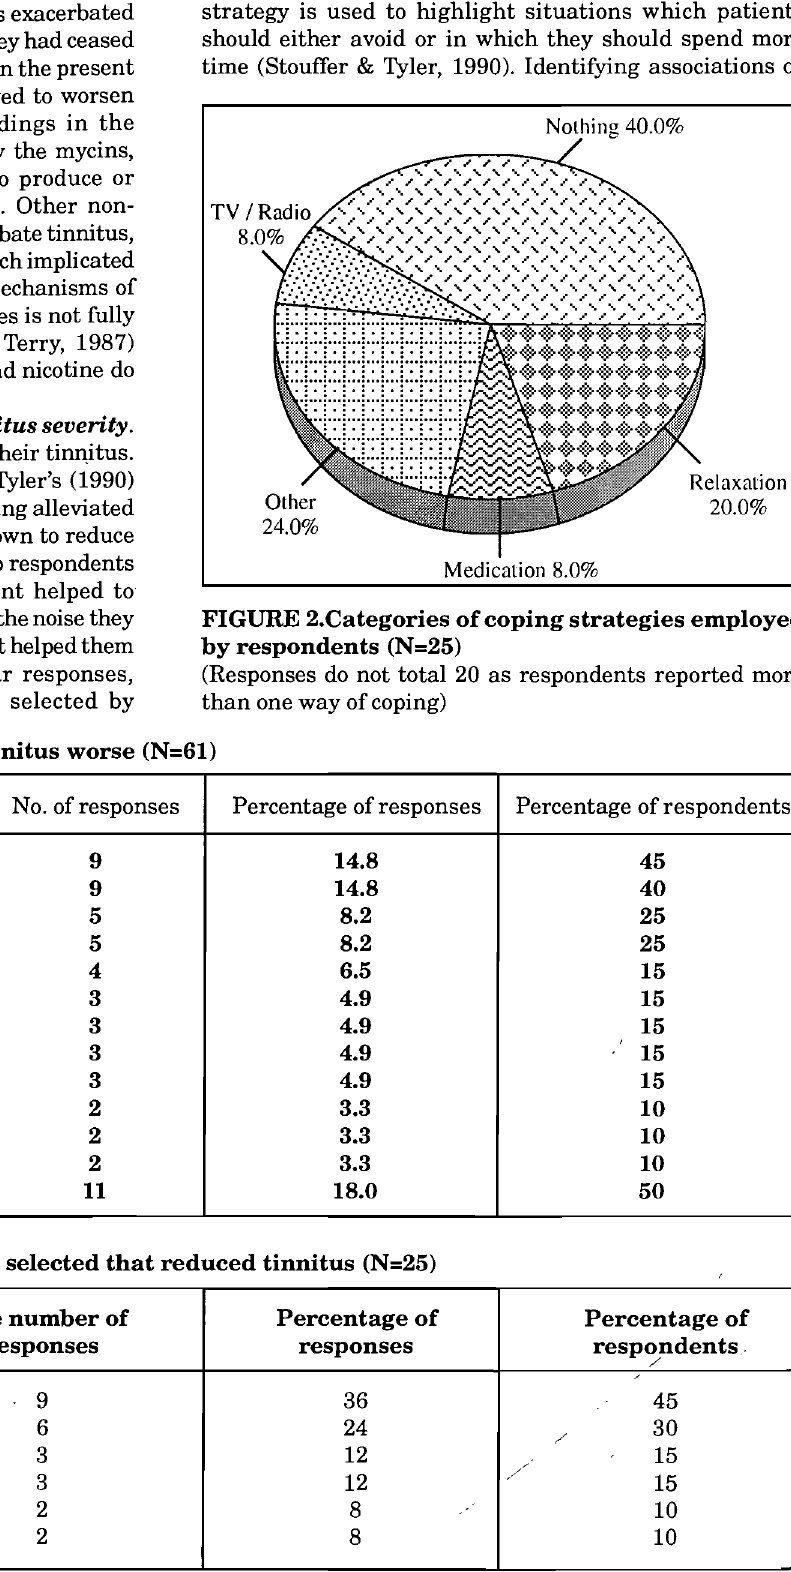
TABLE 7: Responses representing items selected that reduced tinnitus (N=25) Factors that reduce The number of